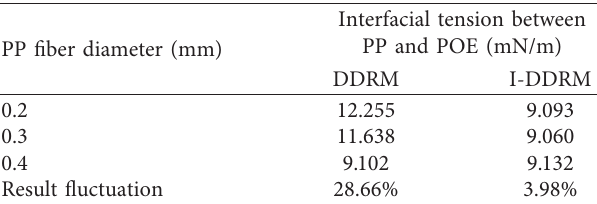
Table 3: The interfacial tension between PP and POE obtained by DDRM and